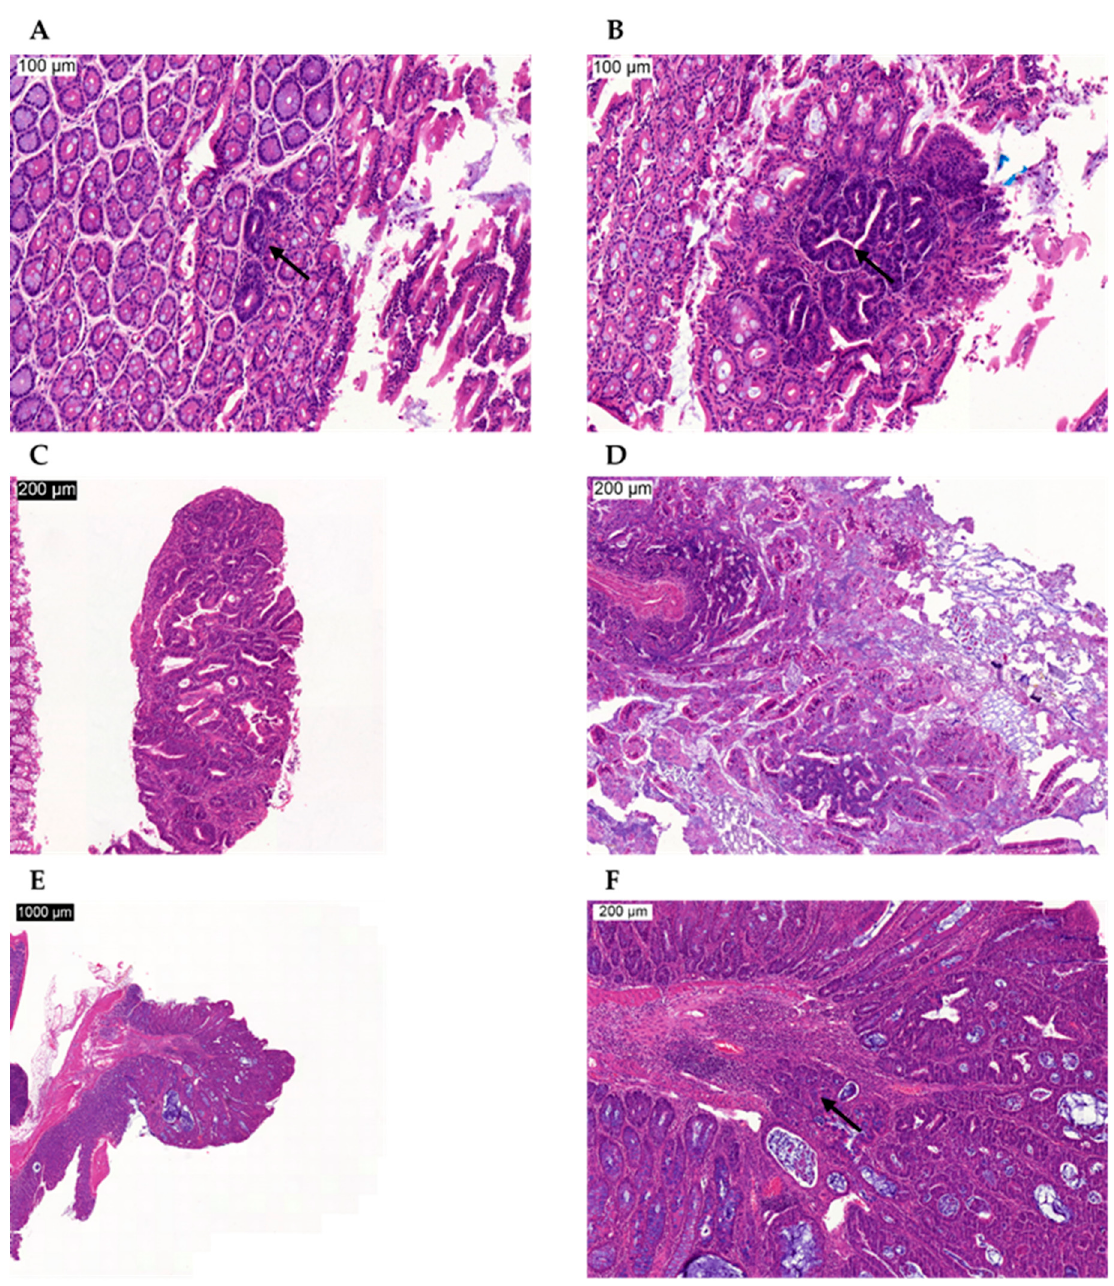
Figure 4. Microscopic images of proliferative lesions in AOM-treated mice. ( A ) Typical hyperplasia, indicated by the arrow, in the large intestine. ( B ) Atypical hyperplasia, indicated by the arrow, in the large intestine. ( C ) Adenoma in the large intestine. ( D ) Adenoma in the small intestine. ( E ) Adenocarcinoma in the large intestine. ( F ) Magnification of the adenocarcinoma in the large intestine (E). The arrow indicates infiltration of the adenocarcinoma in the submucosa. Scale bars are indicated on the images.